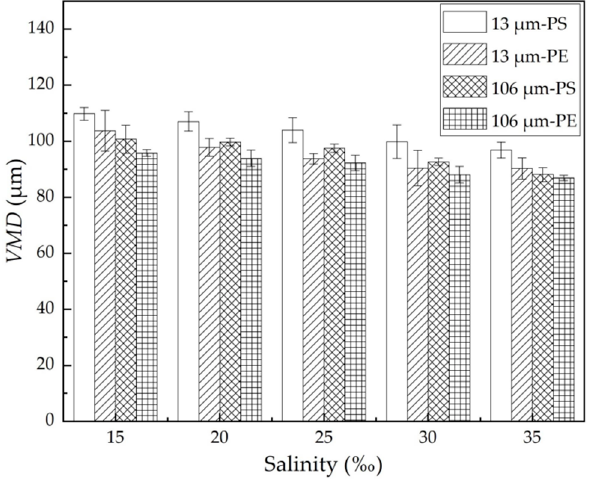
Figure 3. VMD of the dispersed oil droplets with different MPs at different salinity. The error bar represents the standard deviation of the measurements of the three parallel samples.